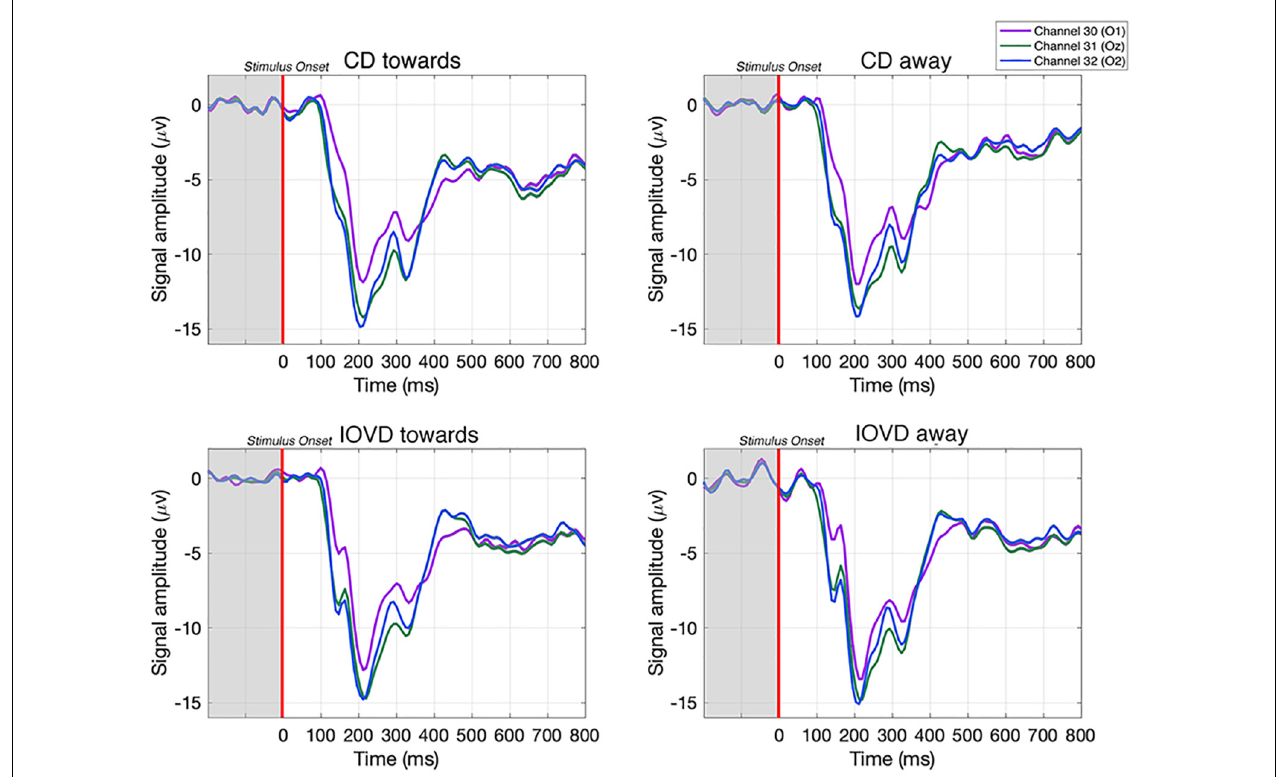
FIGURE 3 | Examples of averaged EEG waveforms from a single participant, taken from three occipital electrodes in response to each stimulus type. Waveforms are averaged over 210 trials. Each epoch is –200 to 800 ms and the stimulus is presented between 0–250 ms. A relative change in EEG signal begins around 100 ms after stimulus